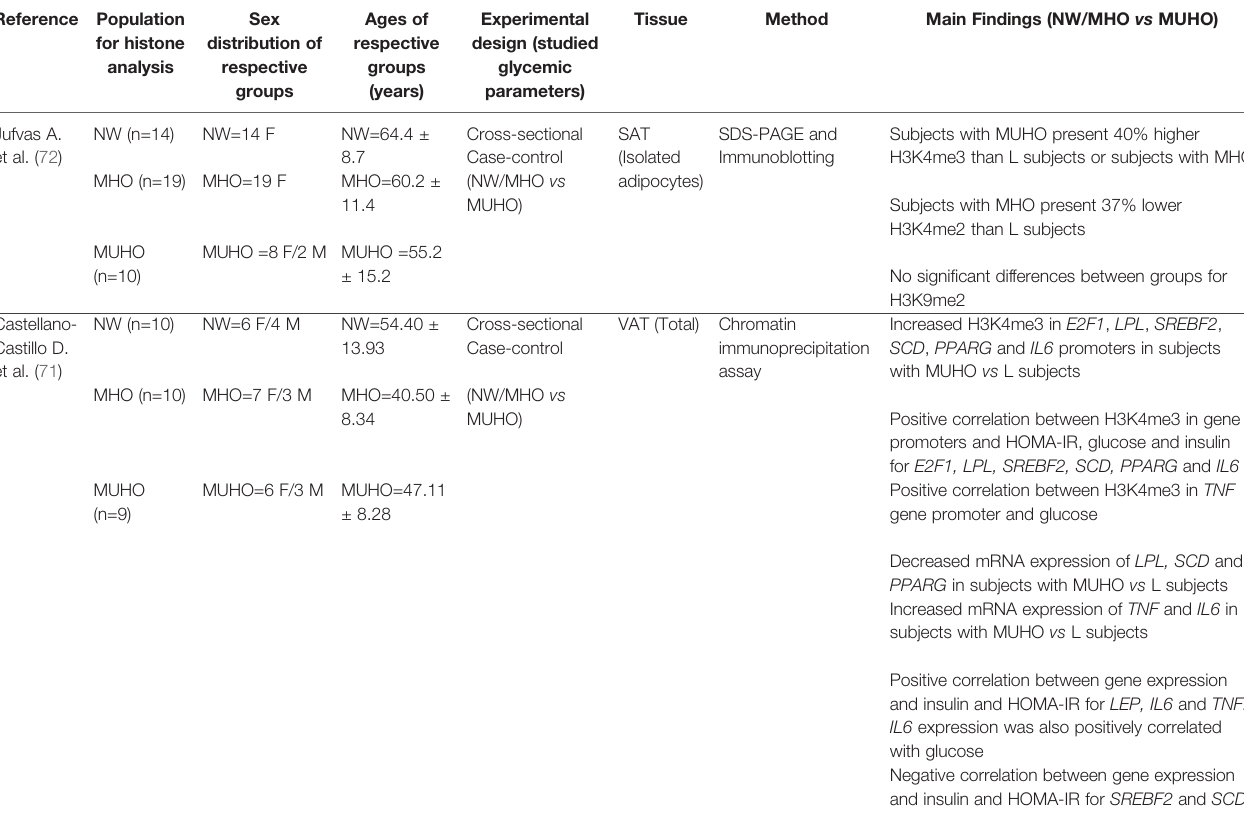
TABLE 3 | Data obtained from studies assessing histone modi fi cations in dysglycemic states or when correlated with glycemic parameters. Reference Population for